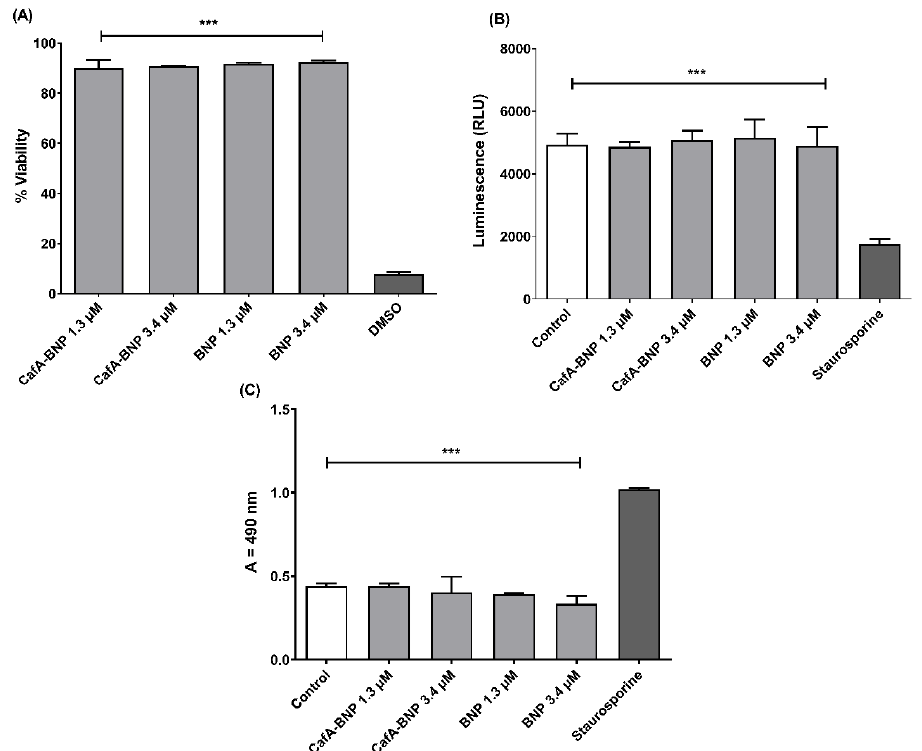
Figure 7. ( A ) TIGK cell viability was assessed after CafA-modified BAR NPs or unmodified BAR NPs administration. CafA-modified BAR NPs and unmodified BAR NPs were non-toxic, relative to cells treated with DMSO. ( B ) ATP levels from CafA-modified BAR NPs and unmodified BAR NPs (1.3, 3.4 µ M) treated cells showed nearly the same level of ATP concentration of control cells (treated with medium only), while ATP levels in the staurosporine-treated cells were significantly lower than the control (treated with medium only), CafA-modified BAR NPs, and unmodified BAR NPs-treated cells (***, p ≤ 0.001). ( C ) No significant release of LDH was observed from TIGK cells treated with CafA-modified BAR NPs and unmodified BAR NPs, relative to control cells. Staurosporine-treated cells demonstrated significantly elevated LDH levels (***, p ≤ 0.001). Data represent the mean ± standard deviation ( n = 3).